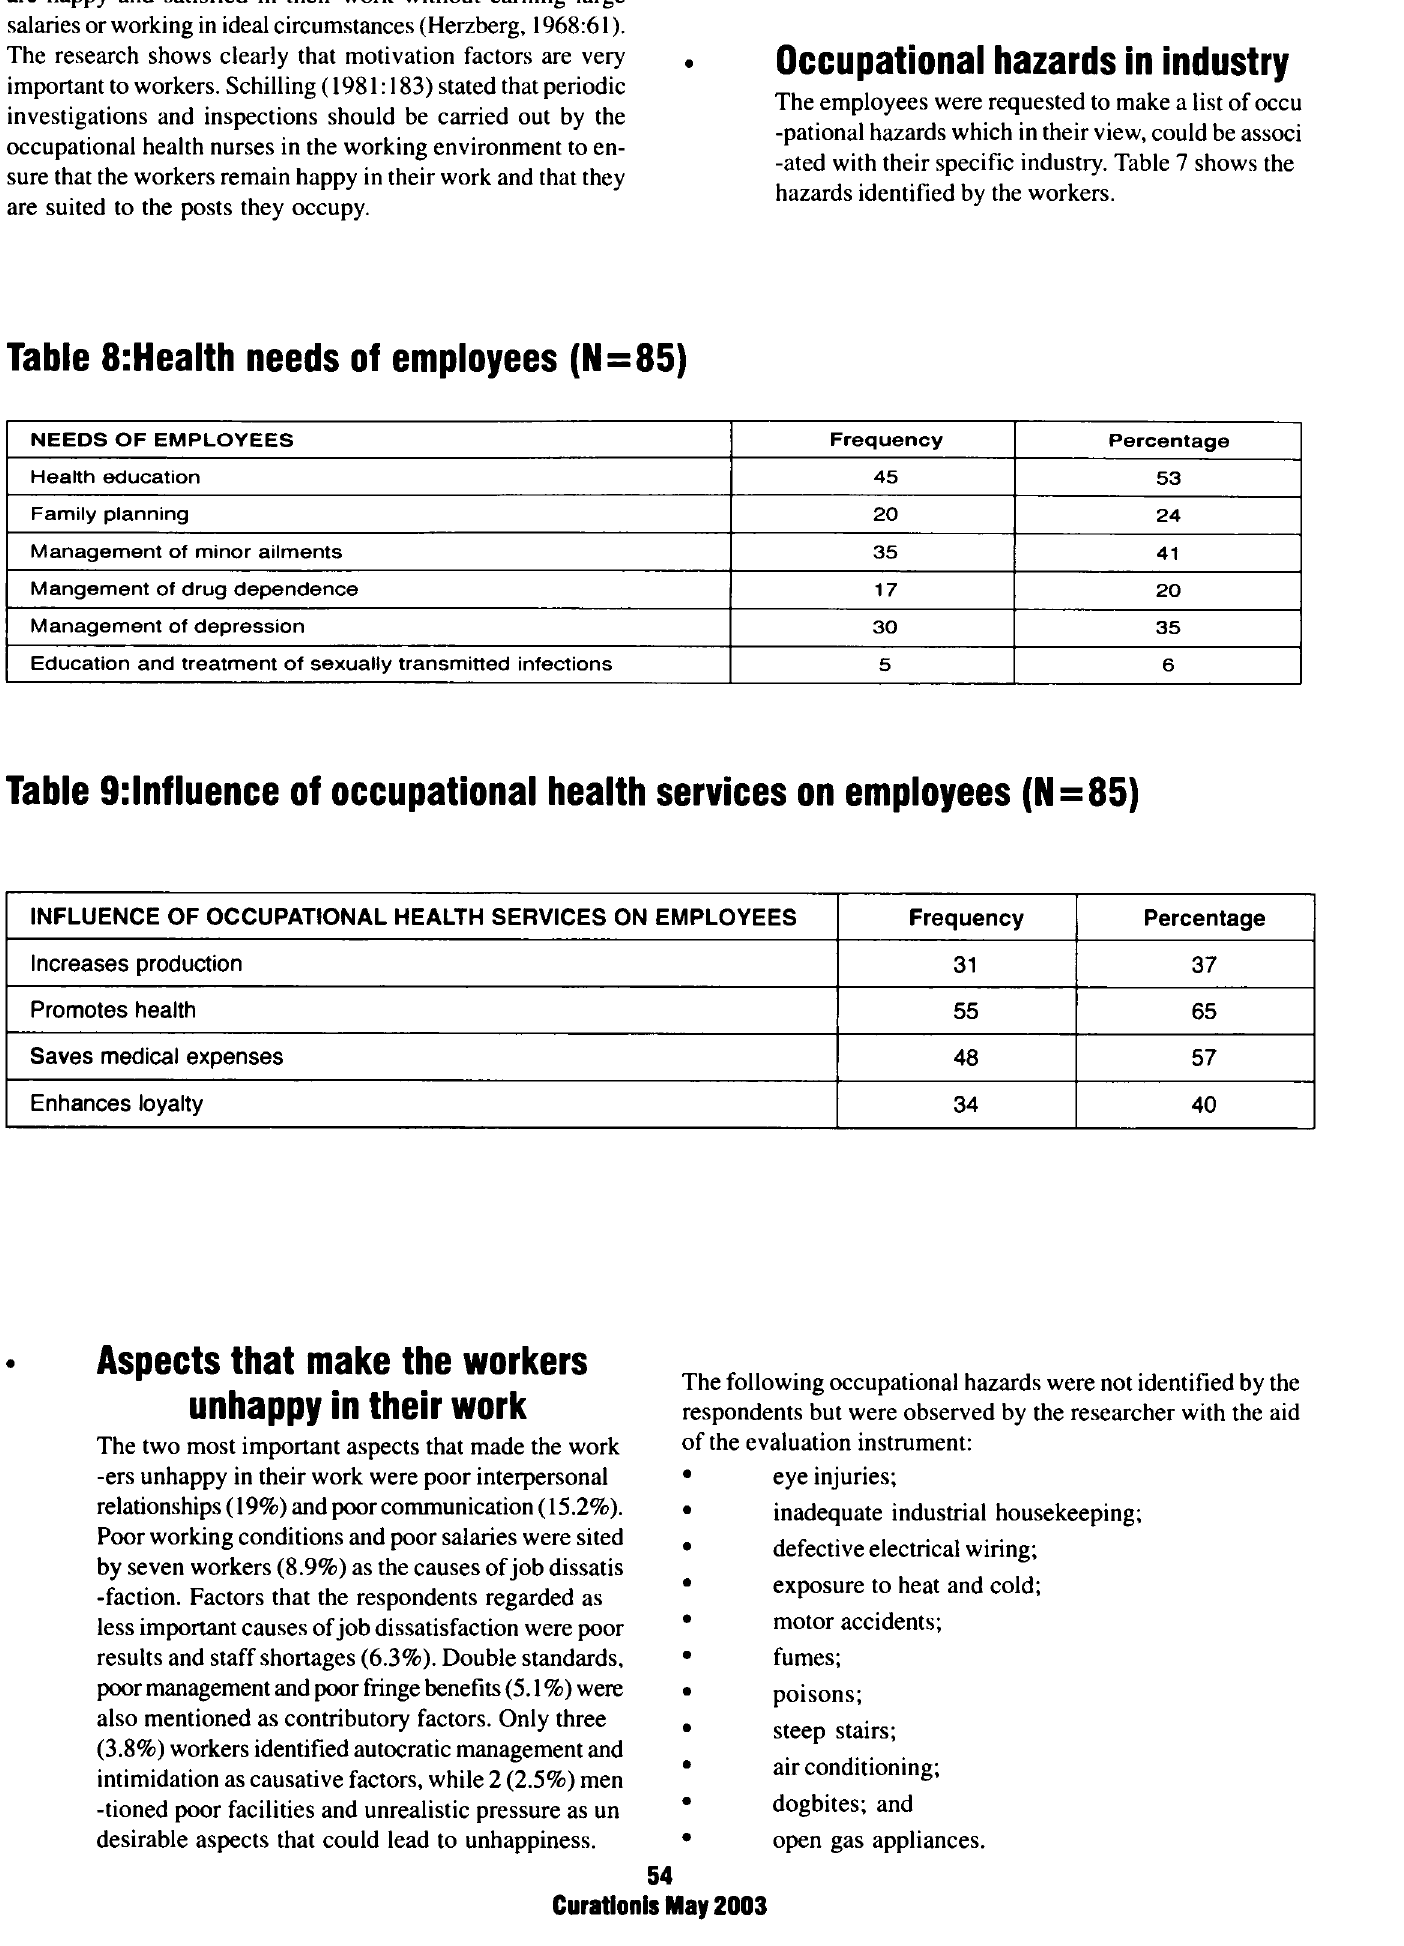
Table 8:Health needs of employees (N=85) NEEDS OF EMPLOYEES